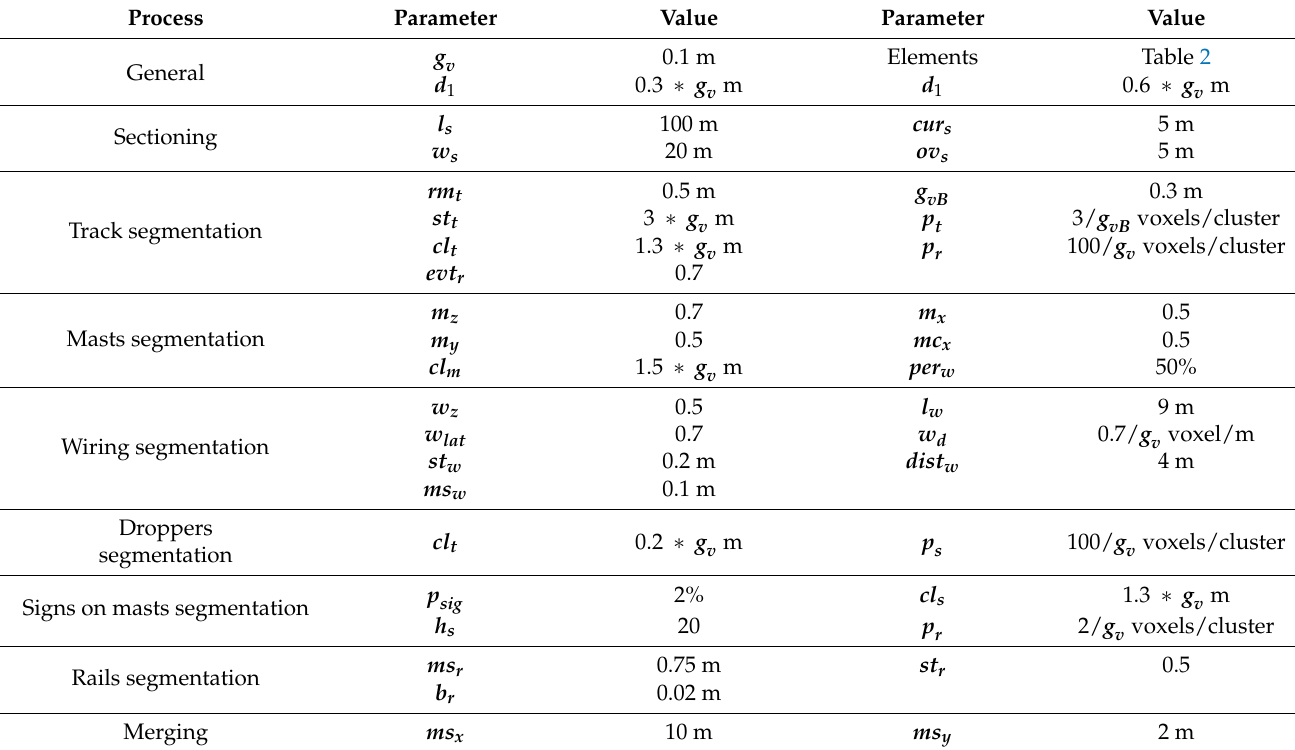
Table 2. Values of the parameters involved in the